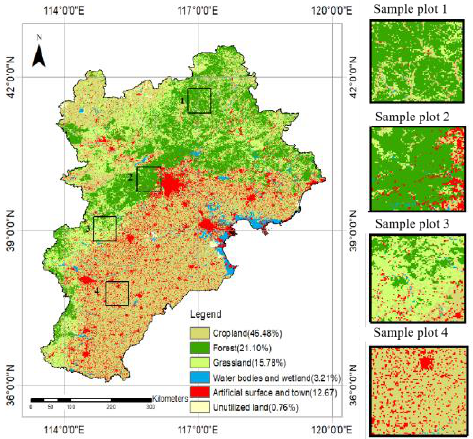
Figure 1. Land use types and the sample plots in the Beijing – Tianjin – Hebei region.